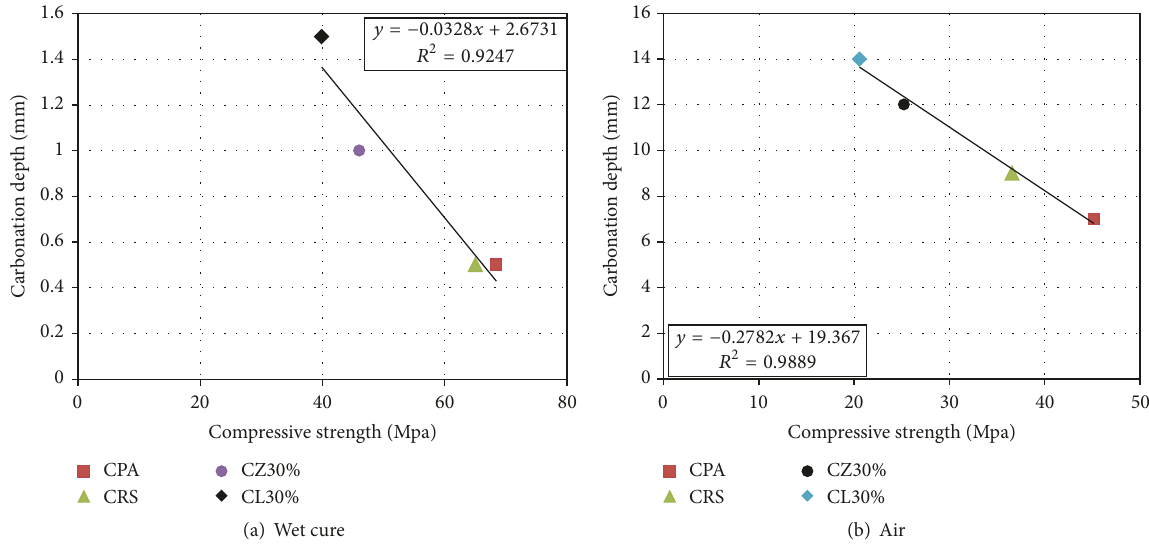
Figure 16: Carbonation depth as a function of compressive strength.